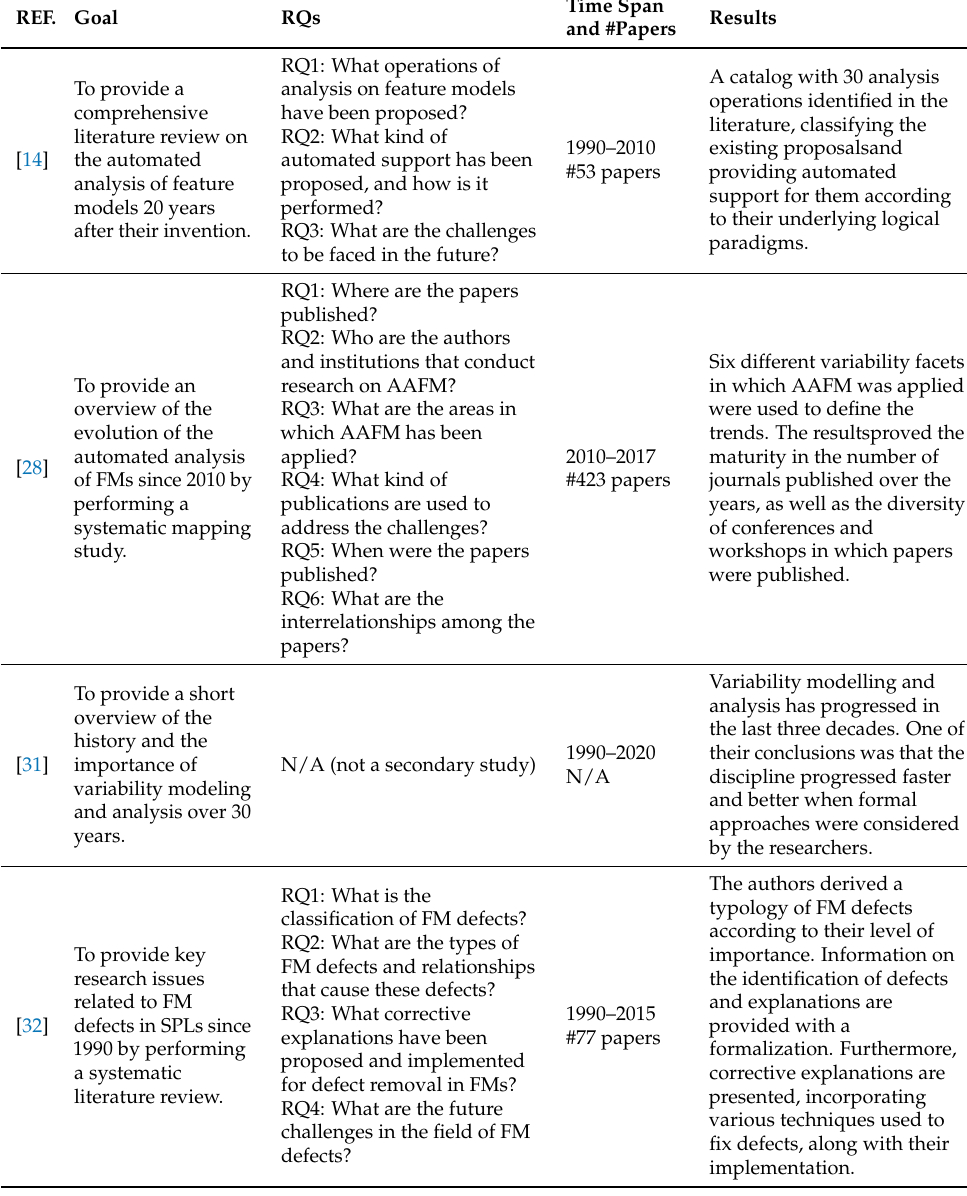
Table A1. Summary of related